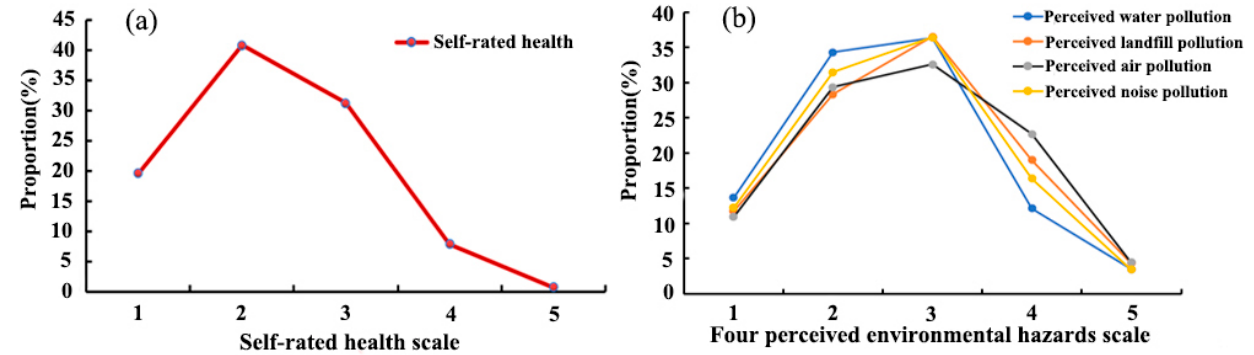
Figure 3. Proportion (%) of residents in self-rated health ( a ) and four perceived environmental hazard types ( b ).